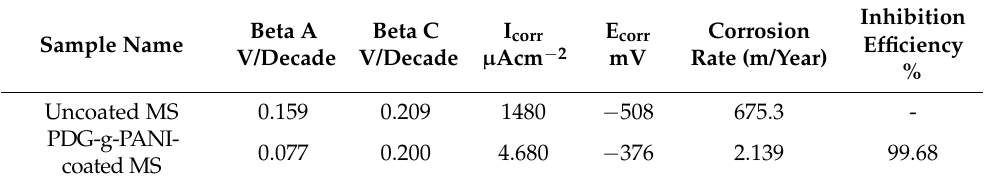
Figure 12. Tafel plot of uncoated MS and PDG-g-PANI-coated MS in 1 M H 2 SO 4 . Table 5. Comparison of essential corrosion kinetic parameters of uncoated MS and PDG-g-PANI- coated MS in 1 M H 2 SO 4 solution.